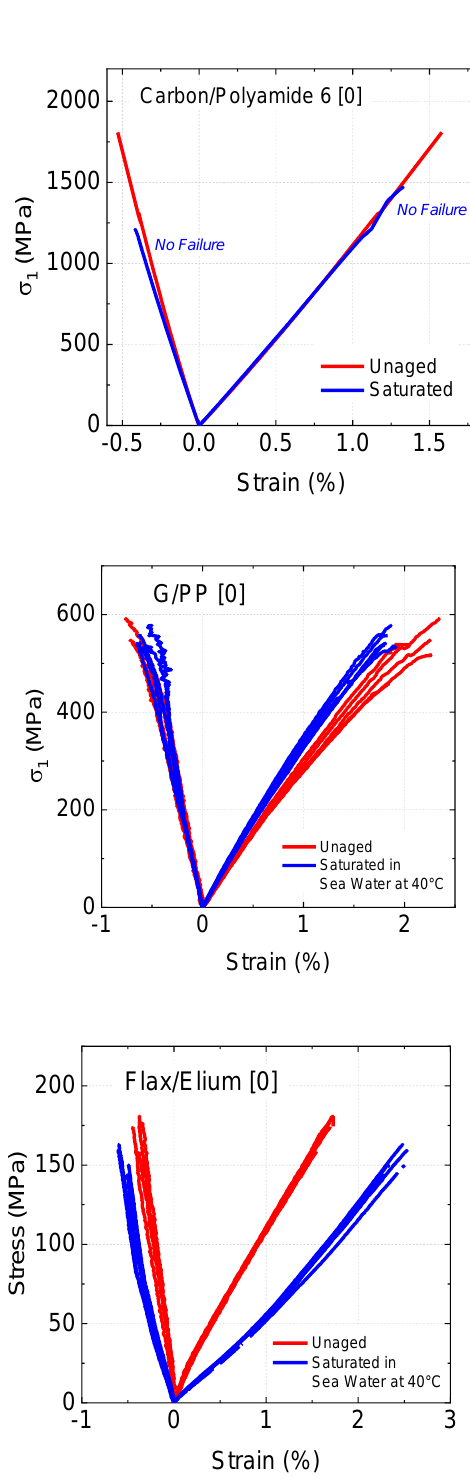
Fig.3. Test results for 0° specimens of three alternative materials, loaded along the fibre direction both dry and seawater